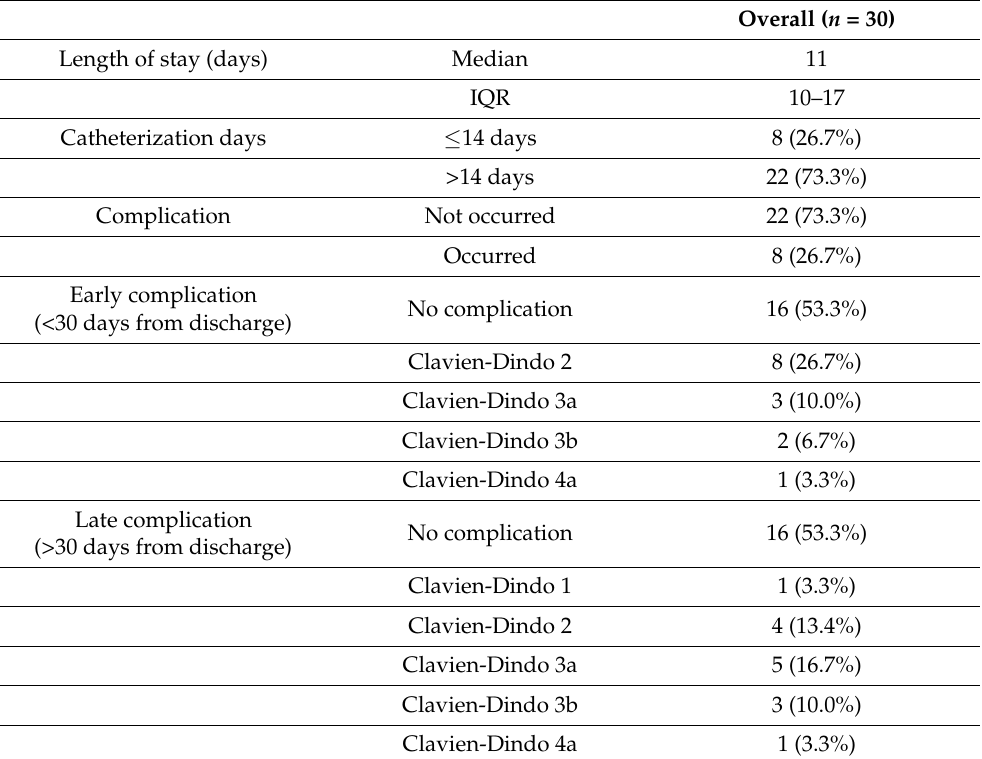
Table 2. Postoperative outcomes of 30 patients with non-metastatic bladder cancer treated with robot-assisted radical cystectomy and Shell-shape ileal ortothopic neobladder reconstruction.